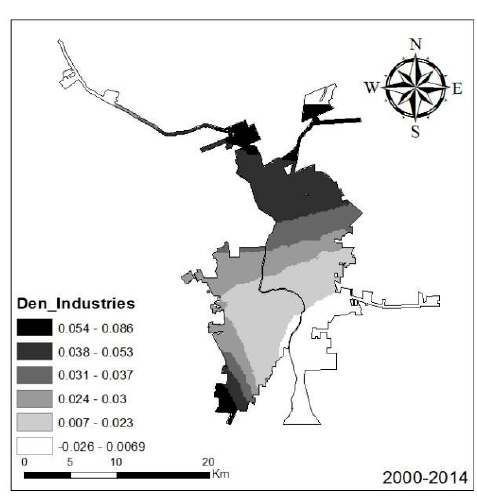
ffi cients for industrial site density, Figure 11. Logistic GWR estimated coefficients for industrial site density, 2000–2014. Figure 11. Logistic GWR estimated coe